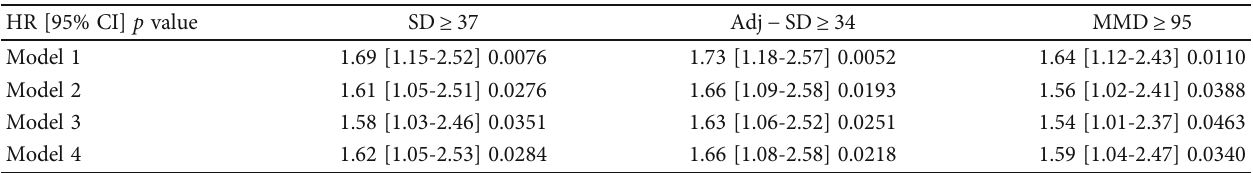
Figure 2: Comparing the eight-year renal survival rate between groups divided by the median values of SD, Adj-SD, and MMD. TG: triglyceride; SD: standard deviation; Adj-SD: SD adjusted for the number of measurements; MMD: maximum minus minimum di ff erence. Table 2: Multivariate Cox ’ s proportional hazard regression model for the association between postprandial TG variability and eGFR decline (primary